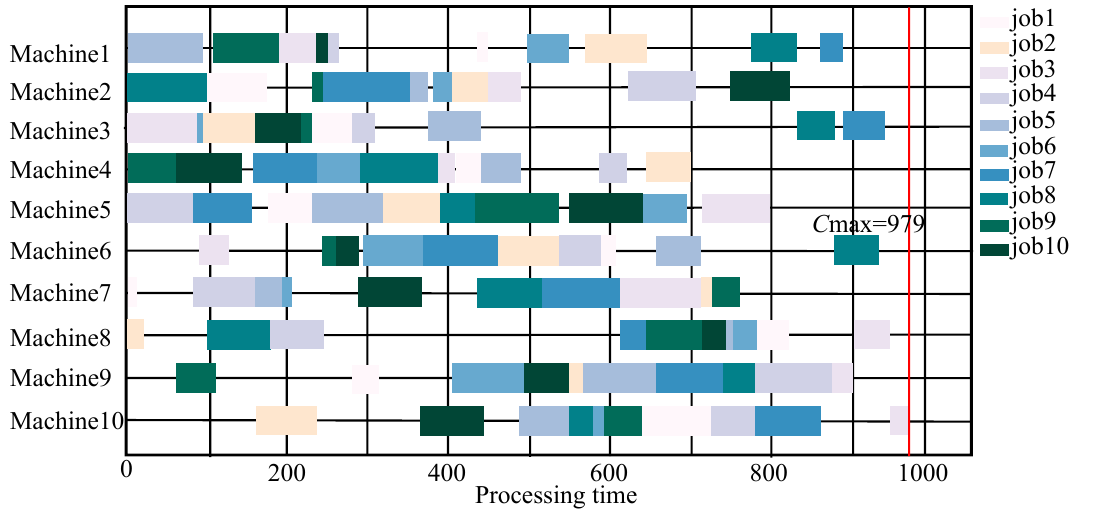
Figure 7. The Gantt chart of LA20.